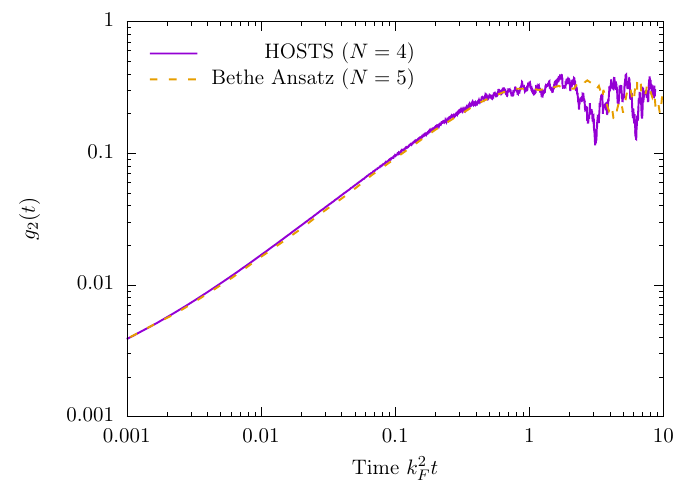
( 0 ) following the 2